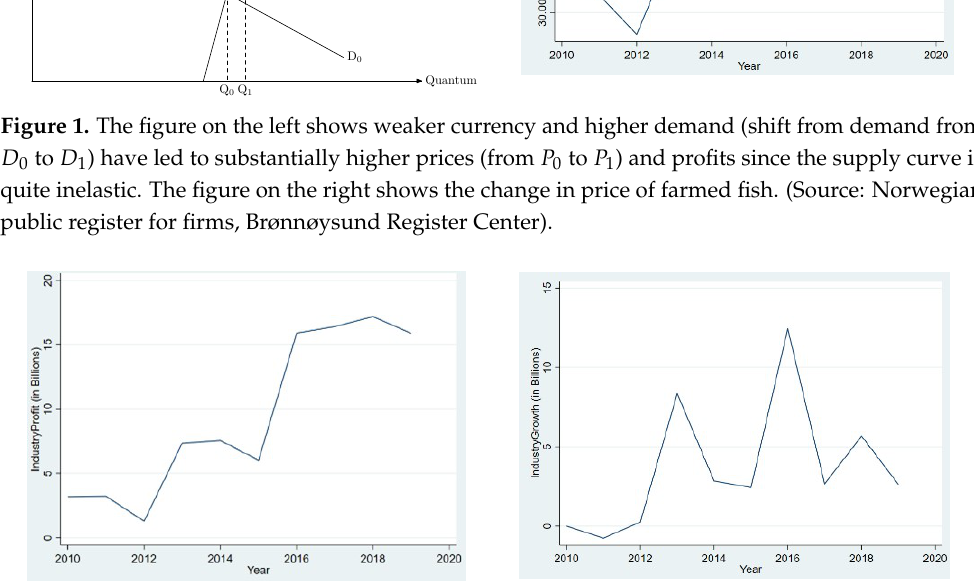
Figure 2. The figure on the left shows the profit, and the figure on the right shows the growth among farmed salmon fishing in Norway from 2010 to 2019 (Source: Norwegian public register for firms, Brønnøysund Register